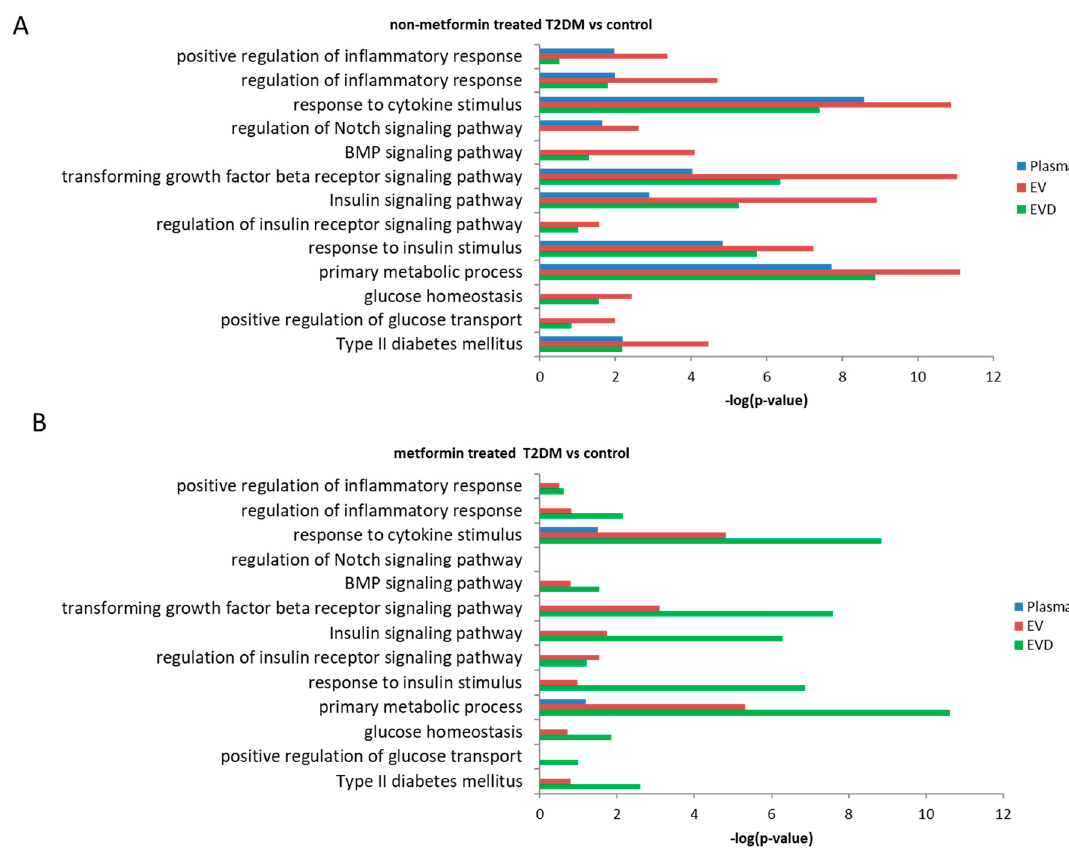
Figure 6. Predicted biological pathways and processes associated with T2DM in whole plasma, EVs, and EV-depleted plasma (EVD). ( A ) non-metformin (non-met) T2DM versus control, ( B ) metformin (met) treated T2DM versus control, Bar graph showing fold enrichment of selected T2DM-realted biological terms/pathways associated with plasma (blue), EV (red), and EVD (green) miRNA targets Values are –log10 transformed FDR corrected p -values.